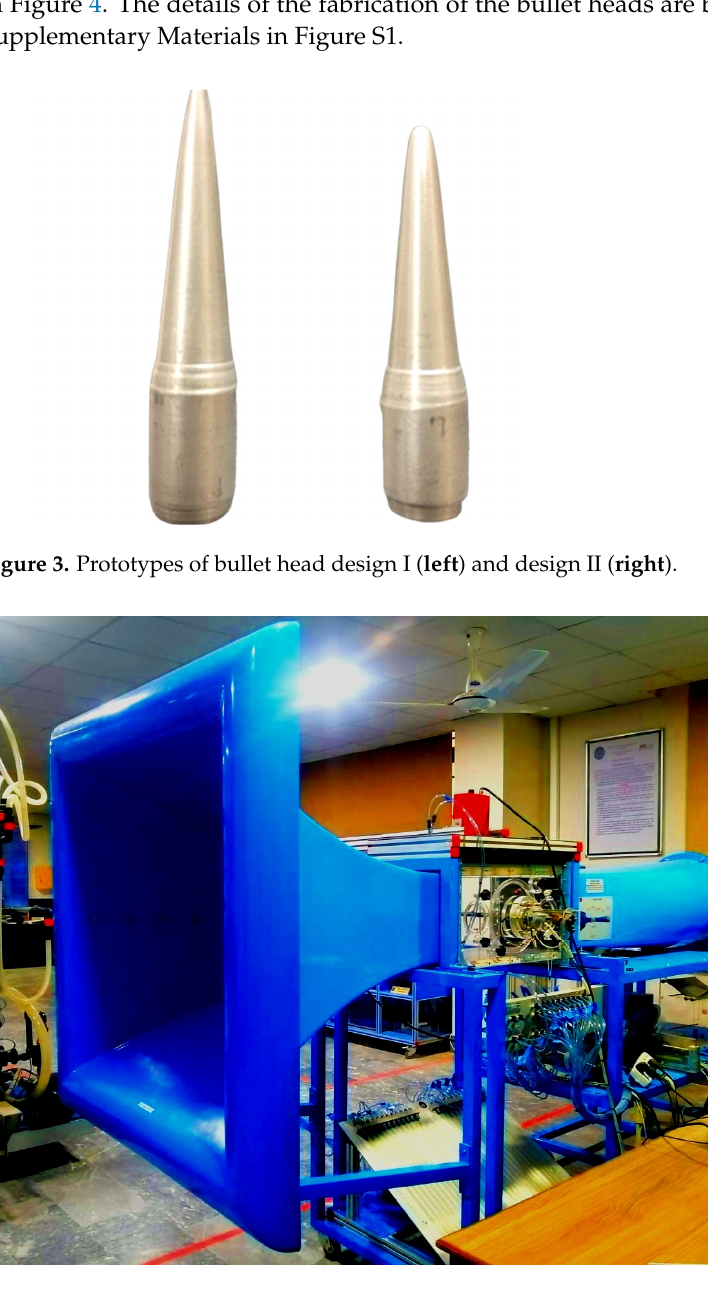
Figure 4. Wind tunnel used in experimental investigation of bullet heads.